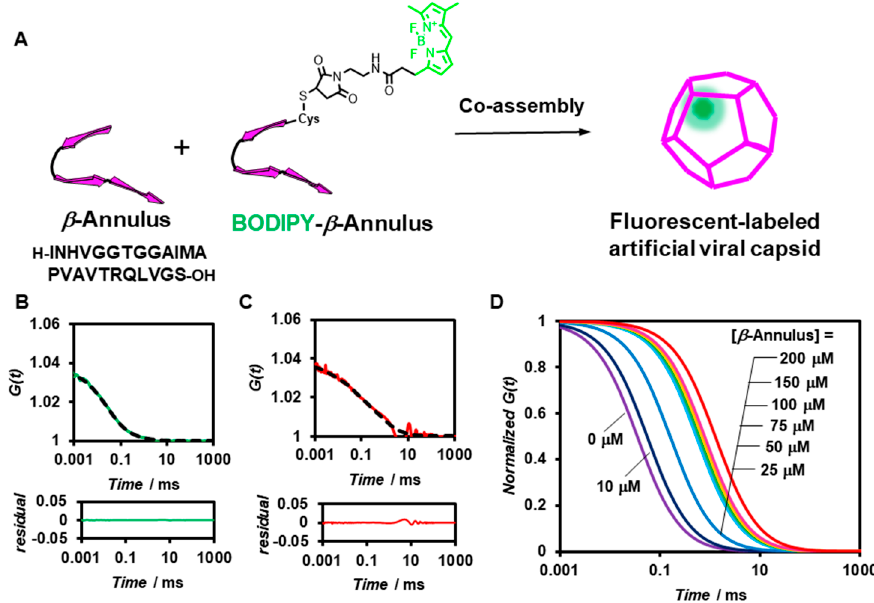
Figure 1. ( A ) Schematic illustration of the construction of a fluorescent-labelled artificial viral capsid by co-assembly of BODIPY- β -annulus and β -annulus peptides. ( B , C ) Measured (solid) and fitted (dot) autocorrelation curves for a 0.1 µ M BODIPY- β -annulus peptide (green) and a mixture of 0.1 µ M BODIPY- β -annulus peptide and 200 µ M β -annulus peptide (red) measured by FCS in 10 mM Tris-HCl buffer (pH 7.0) at 25 ◦ C. The lower graph shows the residual plot. ( D ) Normalized autocorrelation curves of a mixture of 0.1 µ M BODIPY- β -annulus and β -annulus peptides at 0~200 µ M in 10 mM Tris-HCl buffer (pH 7.0) at 25 °C.